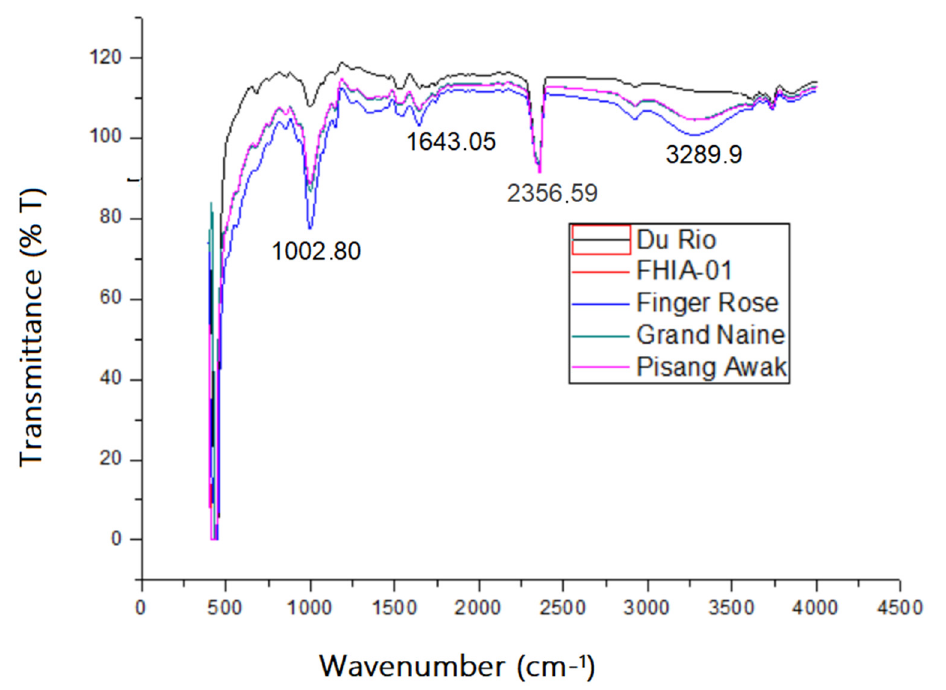
Figure 3. Comparative plots of the FTIR spectra of Du Roi, FHIA–01, Finger Rose, Grand Naine and Pisang Awak.